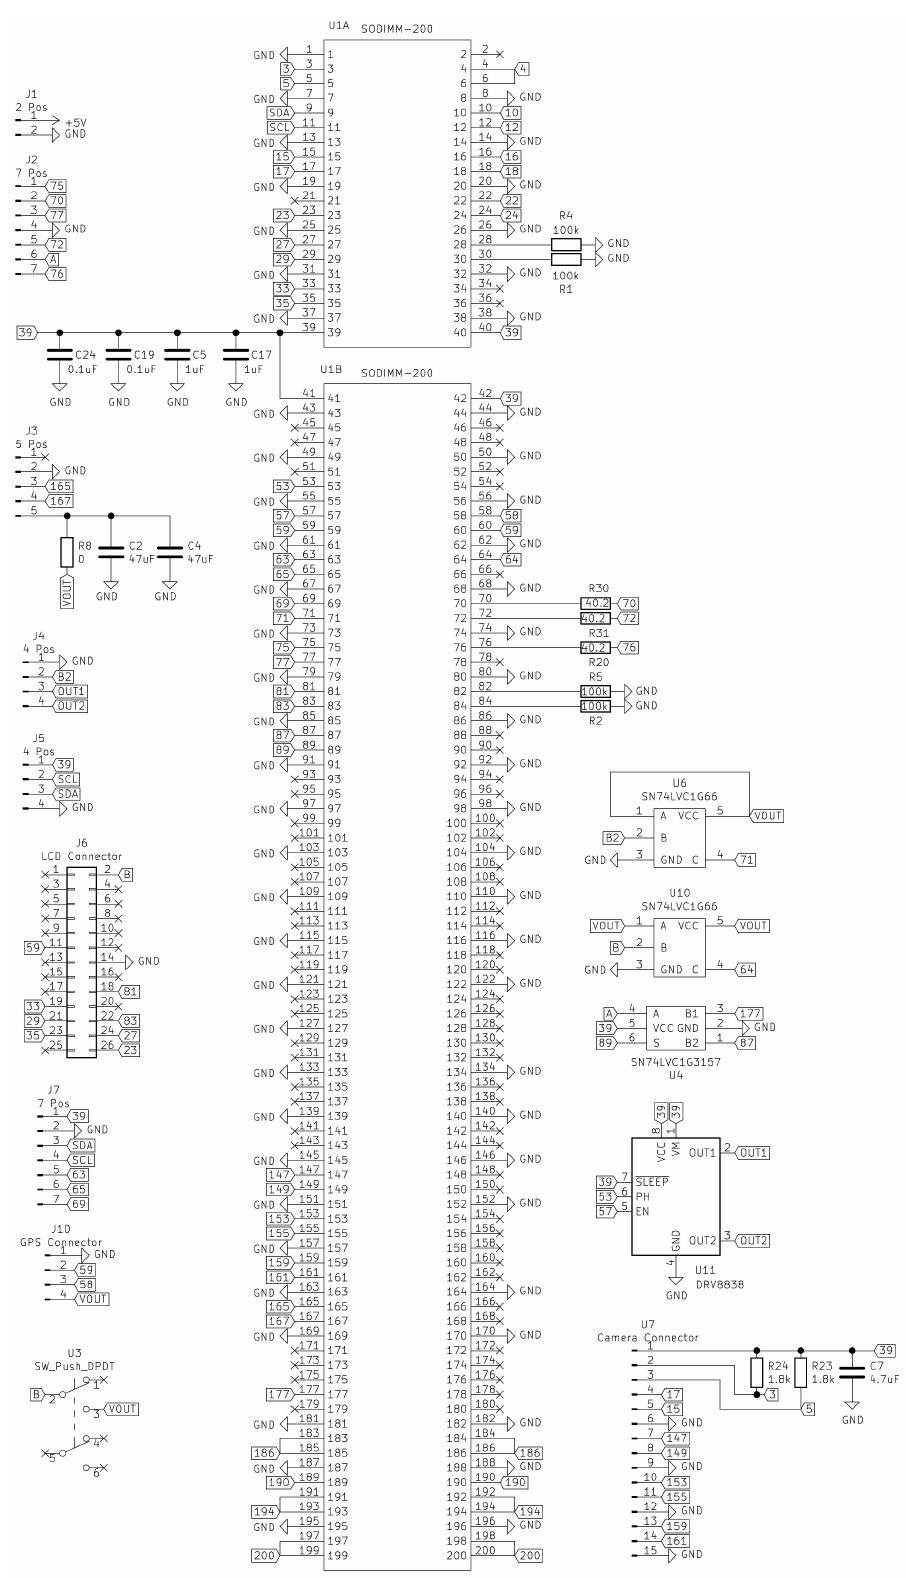
Figure A1. Electronics schematic of the camera